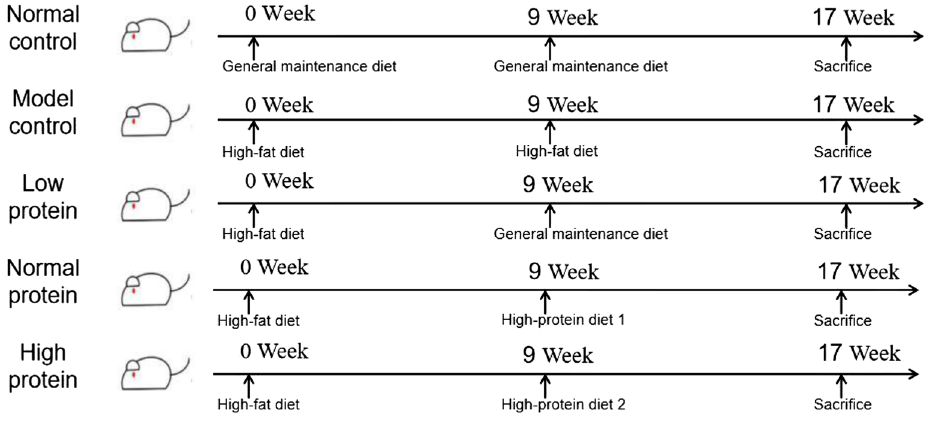
Figure 1. Experimental grouping schedule.